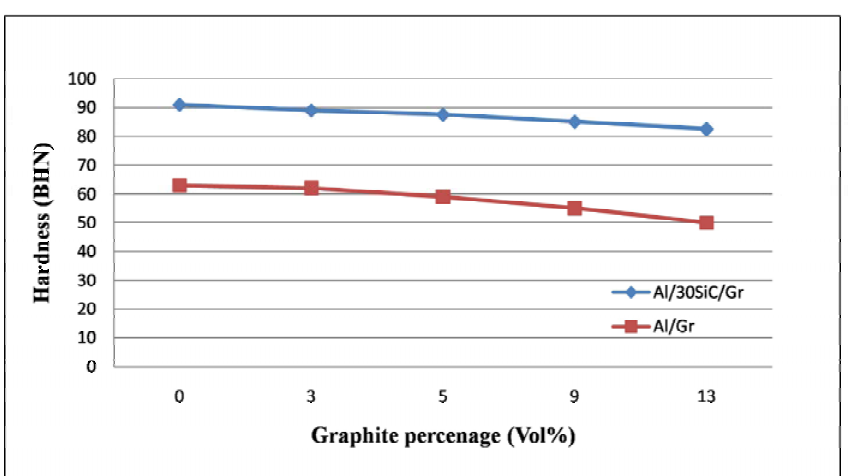
Fig. 7. Hardness values for Al/30SiC/Gr and Al/Gr composites with different volume percent of graphite particles, adapted from